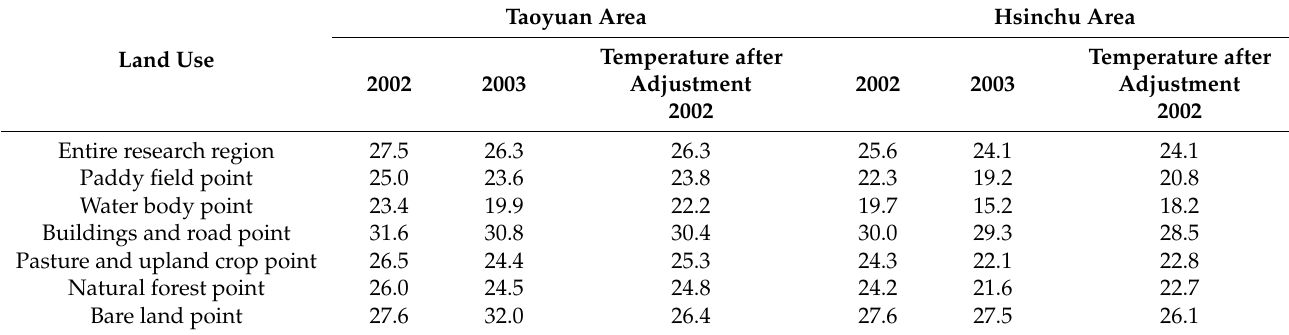
Table 2. The analyzed average surface temperatures ( ◦ C) of the research areas.